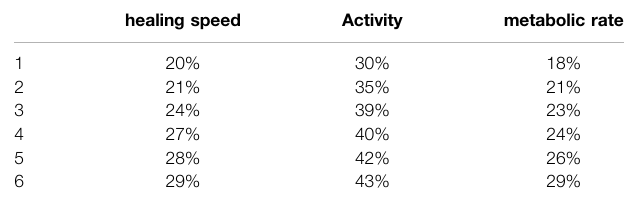
TABLE 2 | Restoration state of meniscus in group A of specimens at 6